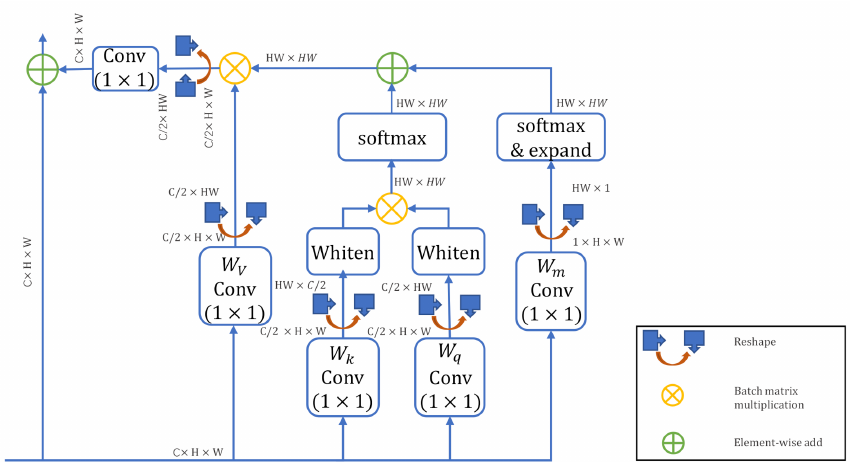
Figure 7. Network structure of disentangled nonlocal (DNL) module, the shape of tensors are represented in dark gray